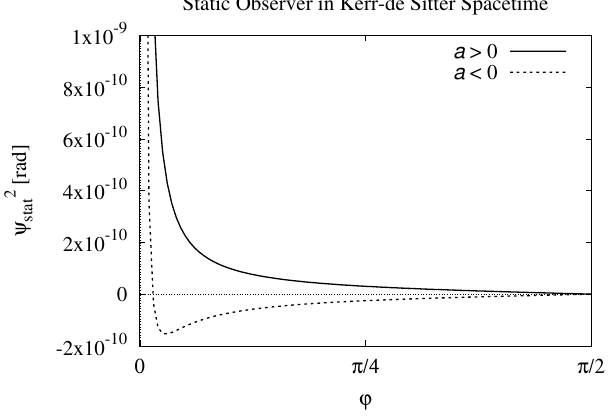
Figure 3. φ dependence of Equation